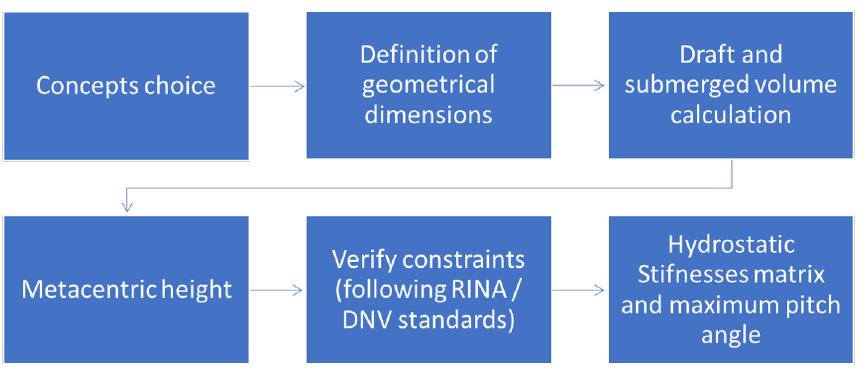
Figure 3. Operating scheme of the hydrostatic